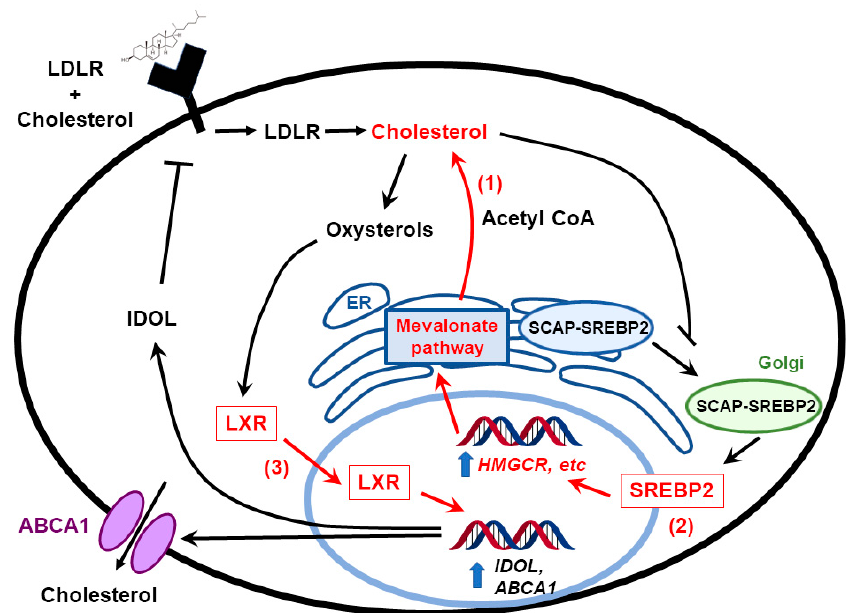
Figure 3. Cholesterol homeostasis in glioblastoma cells. Glioblastoma cells maintain cholesterol under conditions in which normal cells turn it off through multiple mechanisms of dysregulation (highlighted in red). They keep cholesterol biosynthesis on by constitutive activation of the mevalonate pathway (1), and by upregulating SREBPs under hypoxia (2). They are also highly dependent on appropriate levels of LXR activity—hyperactivating LXR with synthetic agonists overstimulates ABCA1 expression and cholesterol efflux, killing glioblastoma (GBM cells) (3). In sum, this provides them with cholesterol in an organ that is blocked from obtaining it from the circulation due to the blood ‐ brain barrier